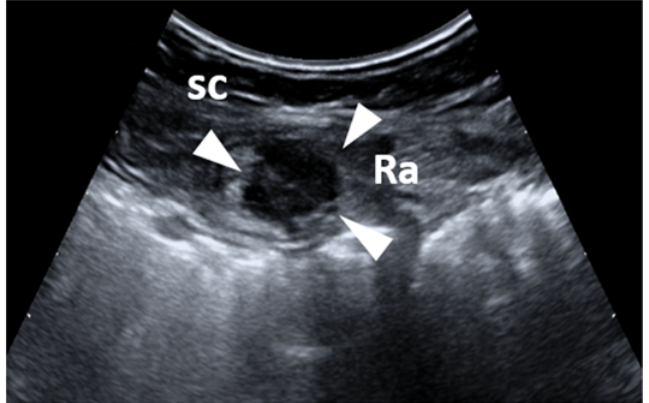
Figure 6. Short ‐ axis sonogram with a convex transducer shows a hypoechoic, nodular mass (white arrow), located on the peritoneal superface, and inside the rectus abdominis (Ra) muscle. sc: subcutaneous tissue.